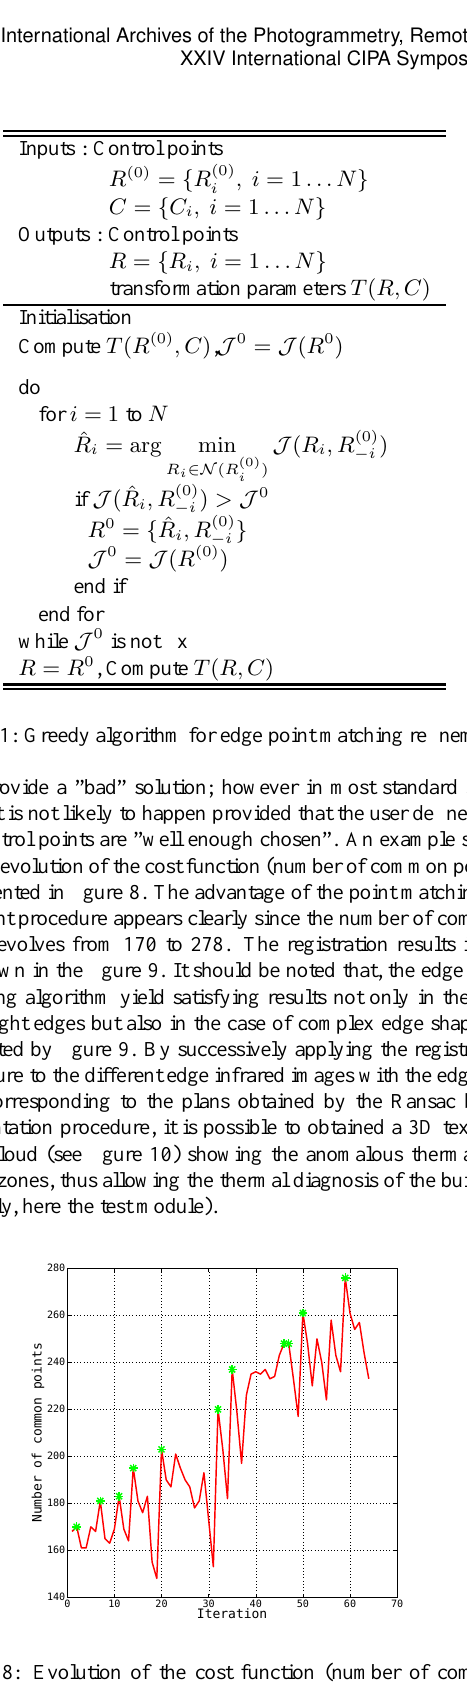
Figure 8: Evolution of the cost function (number of common